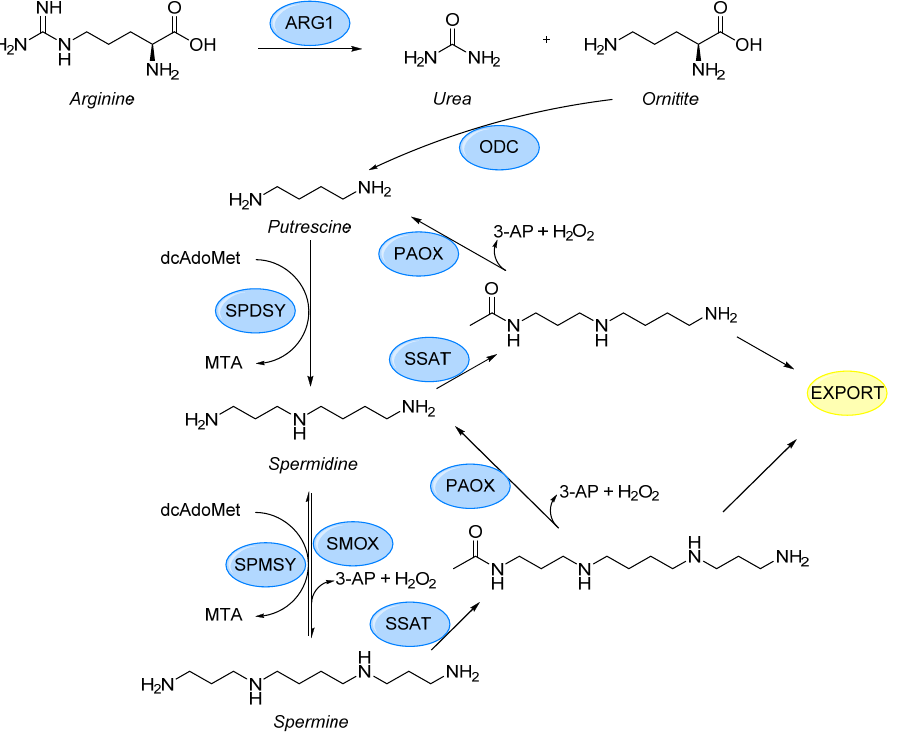
Figure 2. Polyamine